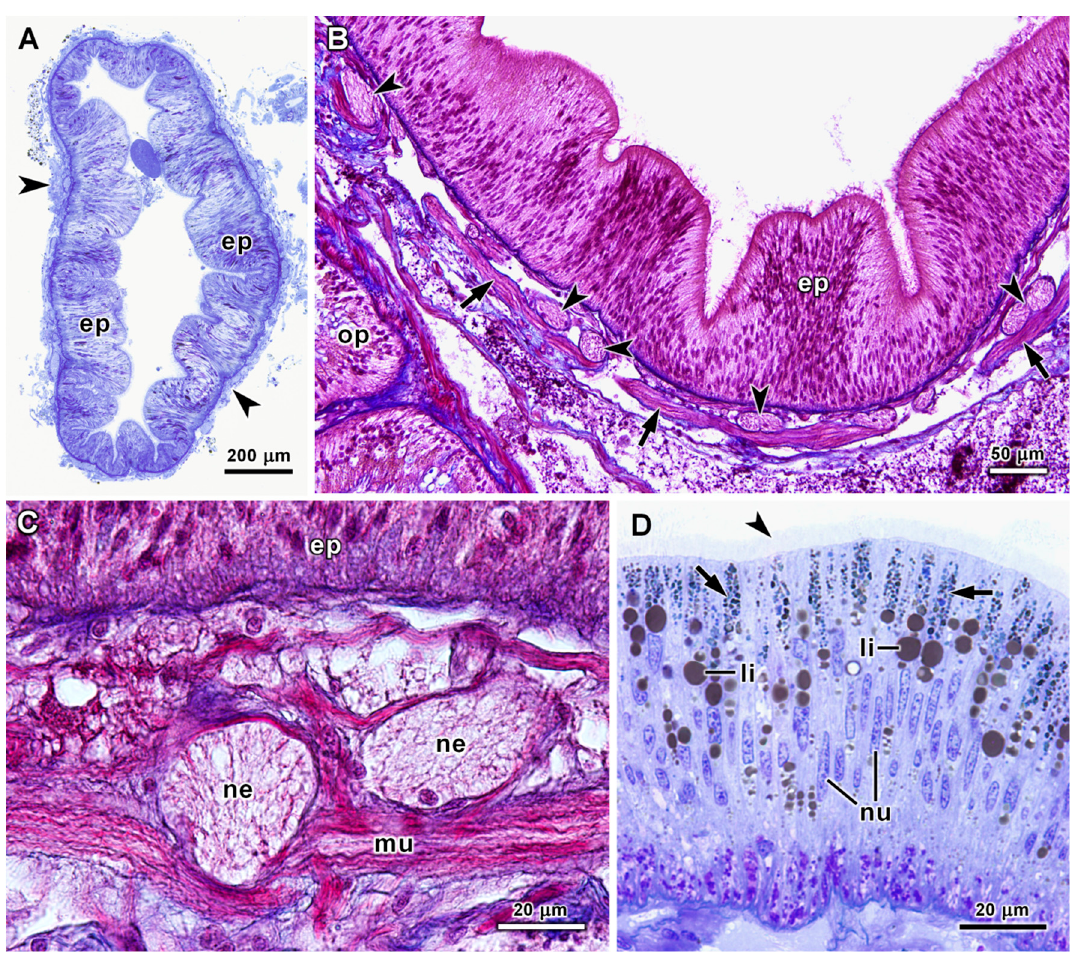
Figure 3. Histology of the oesophagus of A. fascicularis ( A ) and C. angulata ( B – D ). ( A ) Transverse semithin section of the oesophagus. The epithelium (ep) is surrounded by a layer of connective tissue with muscular cells and nerves (arrowheads). Methylene blue and azure II staining. ( B ) Several nerves (arrowheads) and muscle fibres (arrows) surround the oesophageal epithelium (ep). Masson’s trichrome staining. ( C ) Higher magnification view of two nerves (ne) and muscle fibres (mu) below the oesophageal epithelium (ep). Masson’s trichrome staining. ( D ) Absorptive cells with a microvilli border (arrowhead), inclusions in the apical region of the cytoplasm (arrows) and lipid droplets (li) in a semithin section of the oesophagus stained by methylene blue and azure II. nu—nuclei, op—oesophageal pouches (sugar